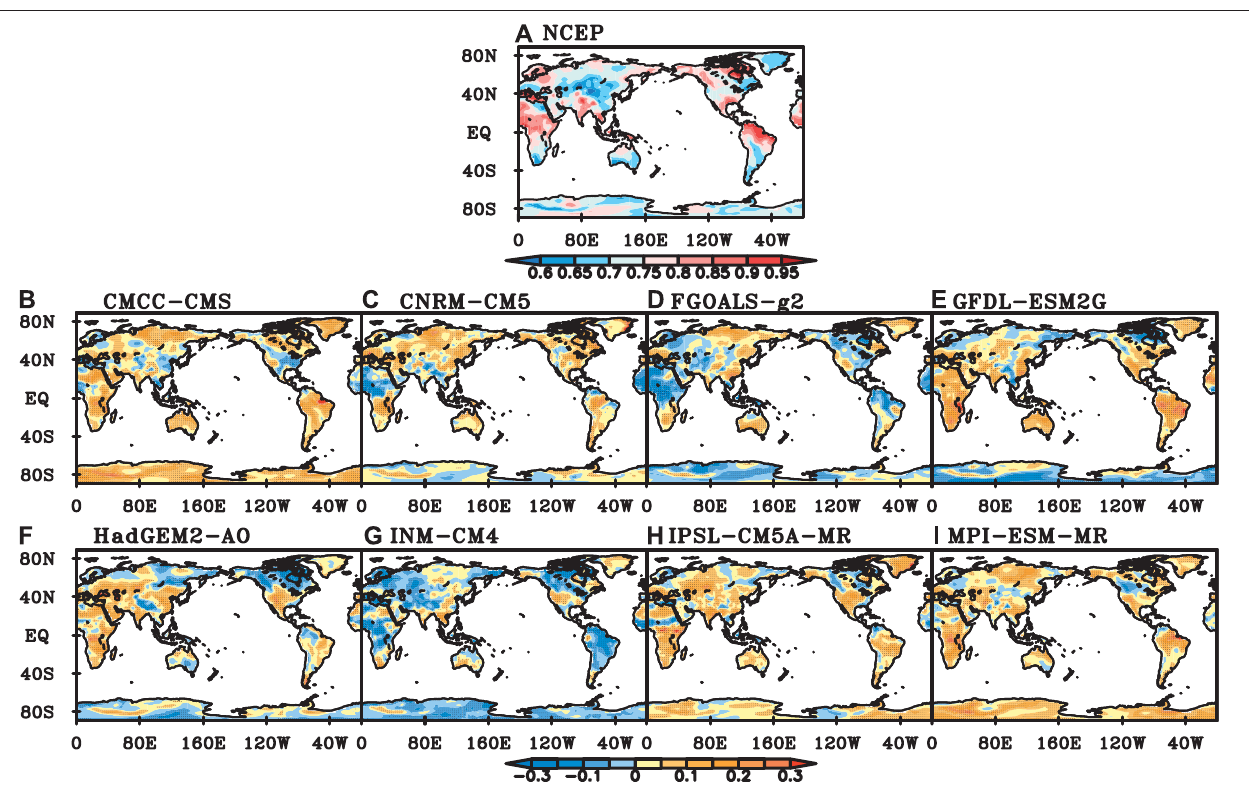
FIGURE 8 | Scaling exponents of NCEP SAT (A) and difference between NCEP and those of SAT simulated by (B) CMCC-CMS, (C) CNRM-CM5, (D) FGOALS-g2, (E) GFDL-ESM2G, (F) HadGEM-AO, (G) INM-CM4, (H) IPSL-CM5A-MR, (I) MPI-ESM-MRinsummer.(Blackdotrepresentsthedifferenceissigni fi cantatasigni fi cancelevelof0.05).